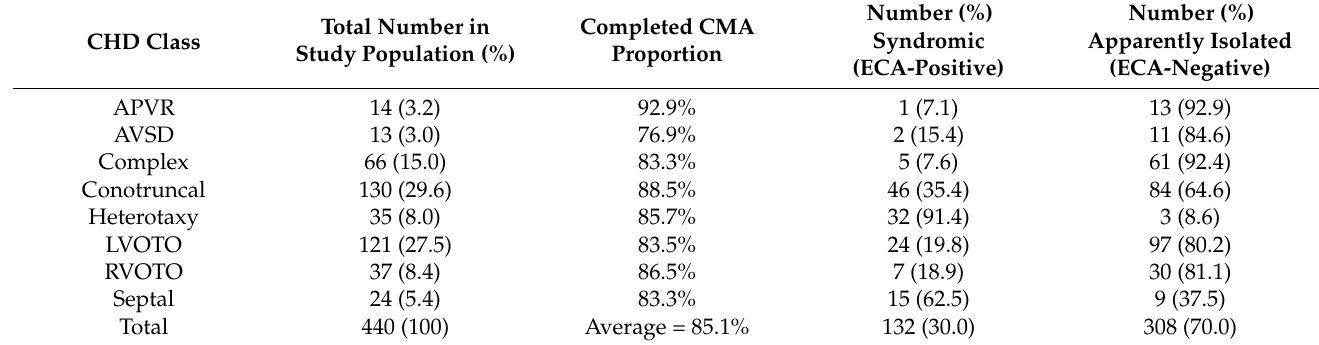
Table 1. Phenotypic classification of neonates and infants with CHDs in the intensive care unit. August 2014–December 2019.